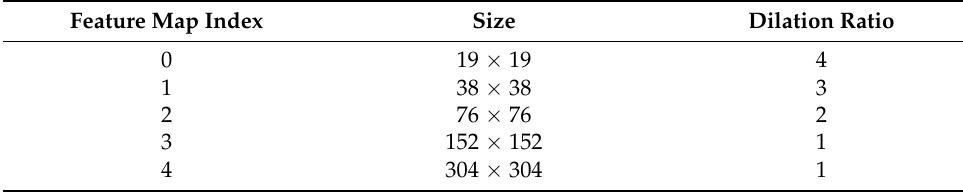
Table 1. The dilation rates of different scale features.